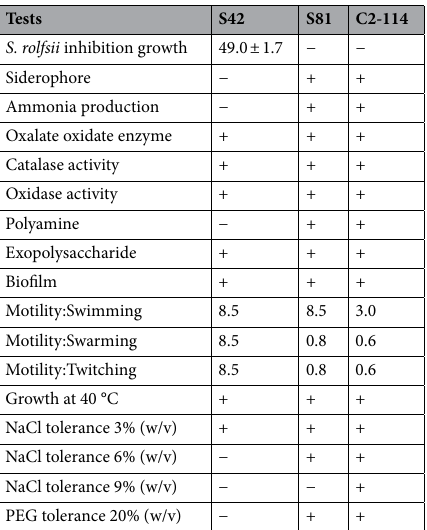
Table 2. Other PGP characteristics and tolerance to stress environment of selective bacteria. Inhibition of S. rolfsii growth presented percentage of inhibition (%); Motility presented diameter (cm); − negative result; + positive result.